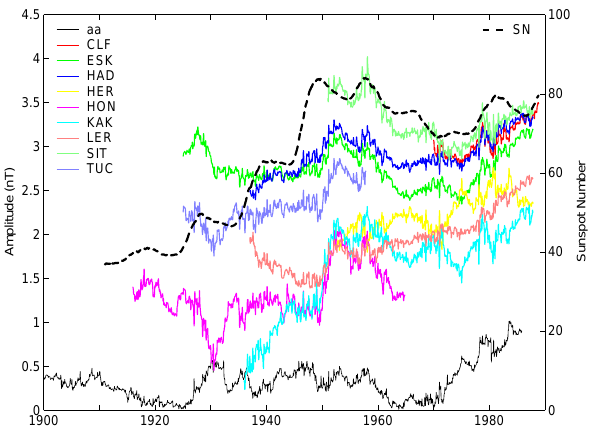
Fig. 8. Time variation of the amplitude of the annual variation of the X component in nine observatories (left ordinate axis), com- puted using a 22-year sliding window, centered. The sunspot num- ber (right ordinate axis) and the amplitude of the annual variation of the aa -index (left ordinate axis), computed using the same window, are also represented.